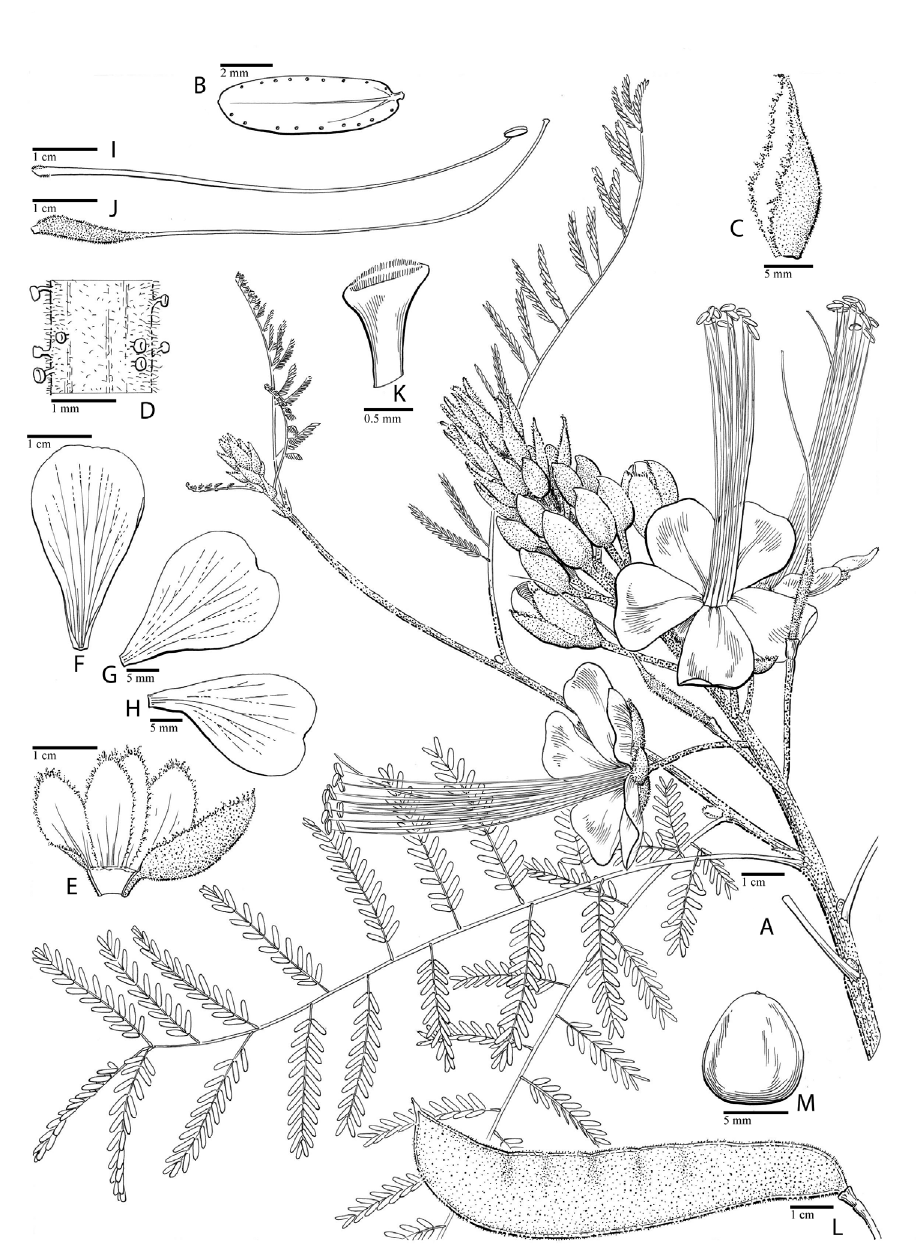
Figure 41. Erythrostemon gilliesii (Hook.) Klotzsch. A inflorescence and foliage B leaflet undersurface with submarginal glands C bract D detail of glandular pedicel E calyx opened out F median petal G up- per lateral petal H lower lateral petal I stamen J gynoecium K stigma L fruit M seed. A from Venturi 5365 B, L from Kiesling et al. 4891 C–K from Cult. Kew 213-69 01878 M from Lewis 1417. Drawn by Eleanor